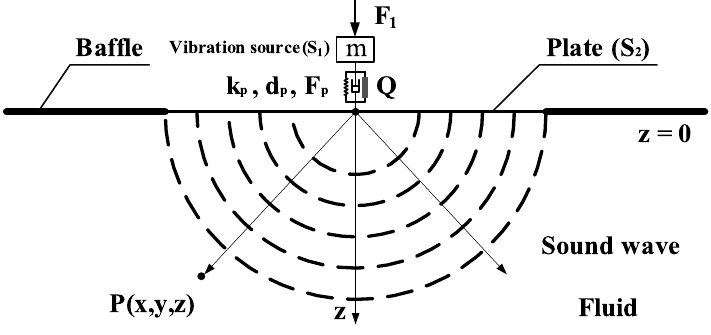
Fig. 1. Rigidly baffled finite plate and active